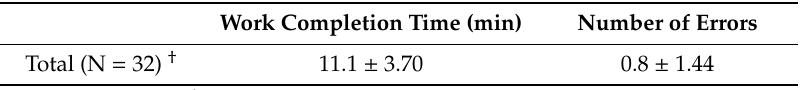
Table 1. Means and standard deviations of milkers’ operating time and number of errors per side (24 stalls) of the milking parlor for animal selection and